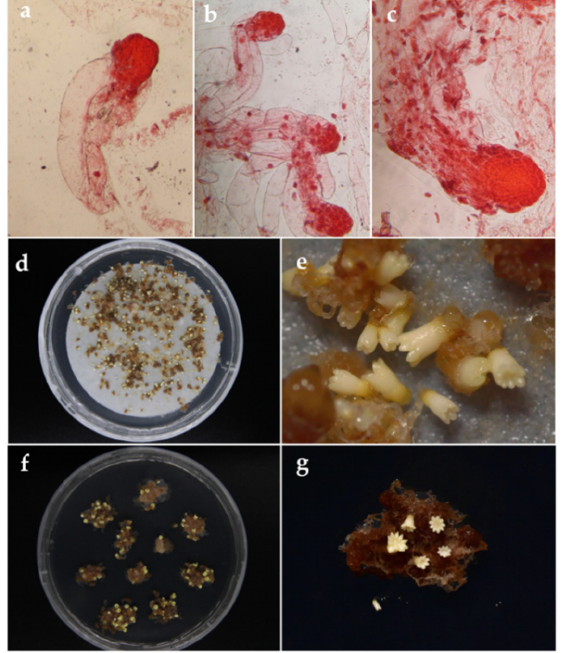
Figure 3. Somatic embryo maturation in L. principis-rupprechtii Mayr. ( a ) PEM I. ( b ) PEM II. ( c ) PEM III. ( d , e ) Dispersion culture. ( f , g ) Piece culture. Bars a, b, c = 50 µm, e = 500 µm, g = 1000 µm.